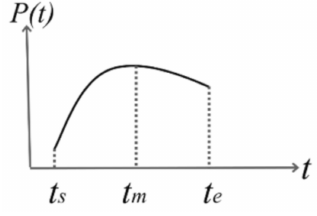
Figure 6. Pose function